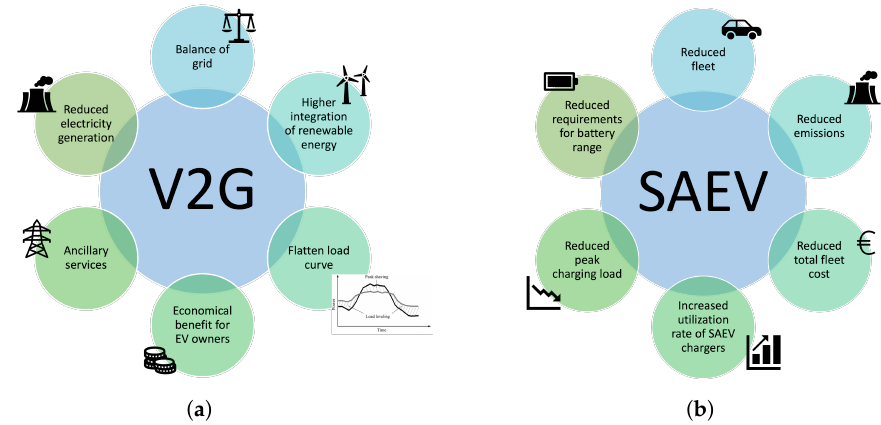
Figure 3. Overview of the values ( a ) for V2G and ( b ) for SAEVs. Source: Adapted from [1].